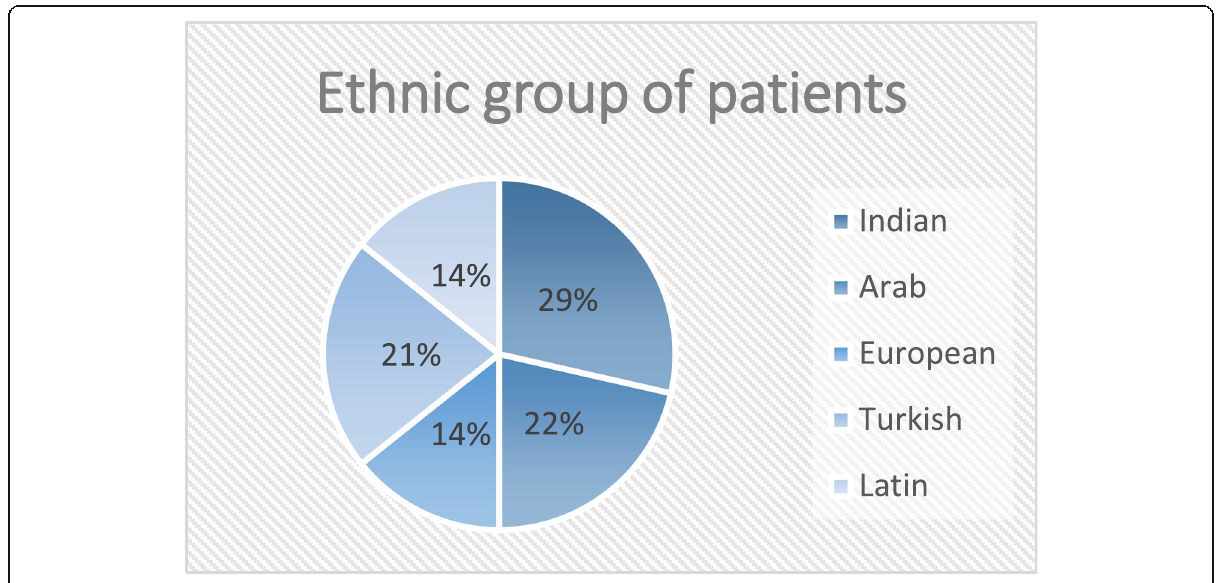
Fig. 7 Age ethnic groups in patients with bilateral antrochoanal polyps [8 –